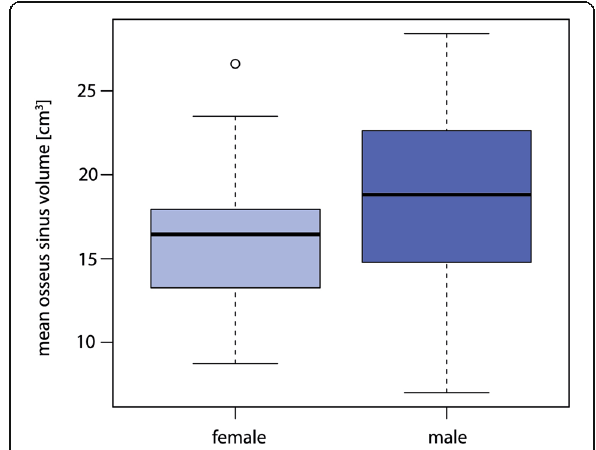
Fig. 8 The association between mean osseus sinus volume of the maxillary sinus and gender. Men have a statistically significant higher mean osseus volume than women ( p =